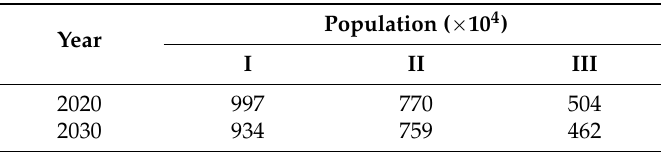
Table 5. WRDCC of Chengdu city in 2020 and